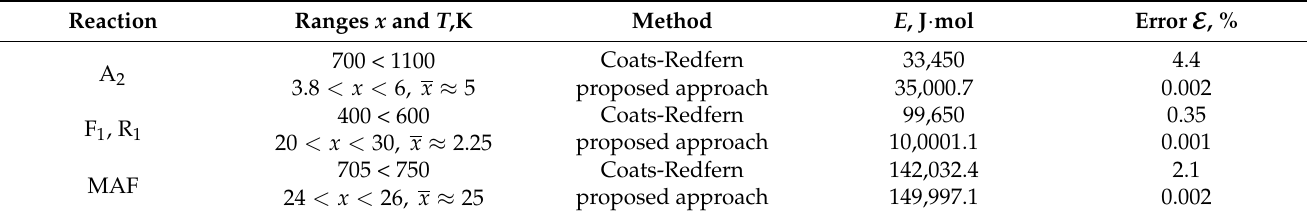
Table 3. Percentage error E in determining the activation energy E . Reaction Ranges x and T ,K